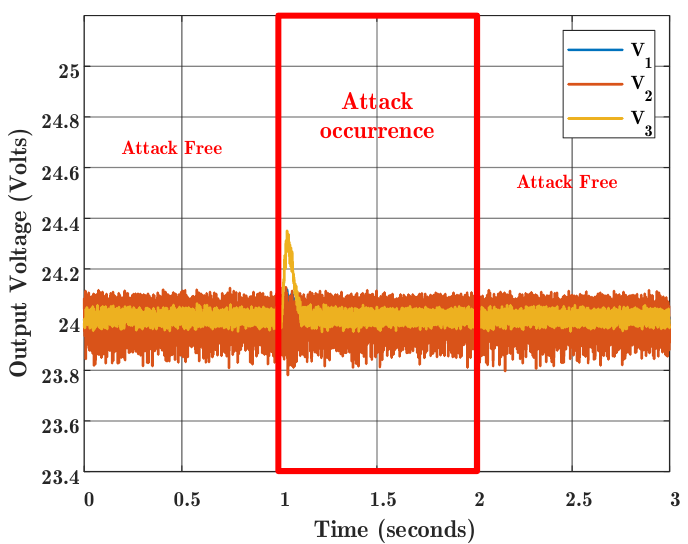
Figure 10. Experimental result for proposed consensus algorithm. FDI attack occurred at time 1 s and was removed at time 2